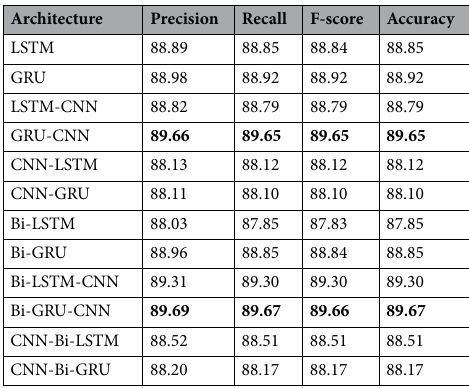
Table 5. Comparison of applied models’ performance on the hybrid dataset. Significant values are in given in bold.